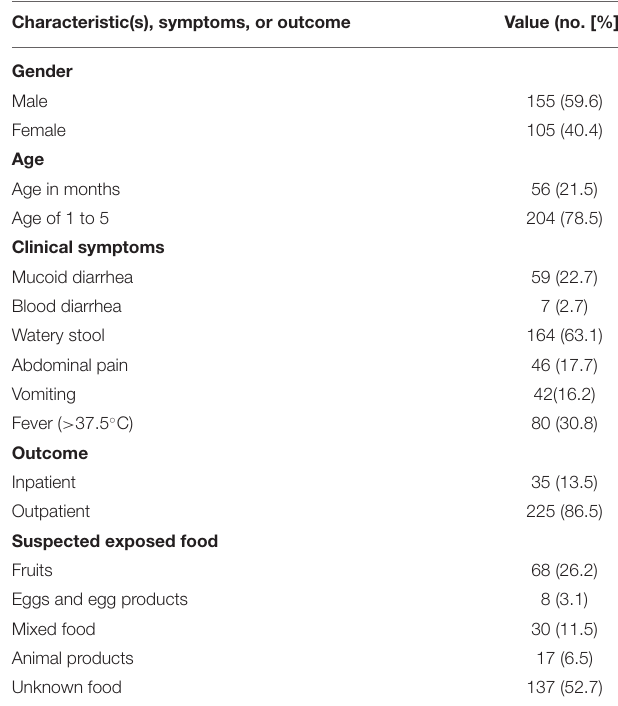
TABLE 1 | Demographic and epidemiology features of diarrheal children infected with nontyphoidal Salmonella (NTS) ( n = 260). Characteristic(s), symptoms, or